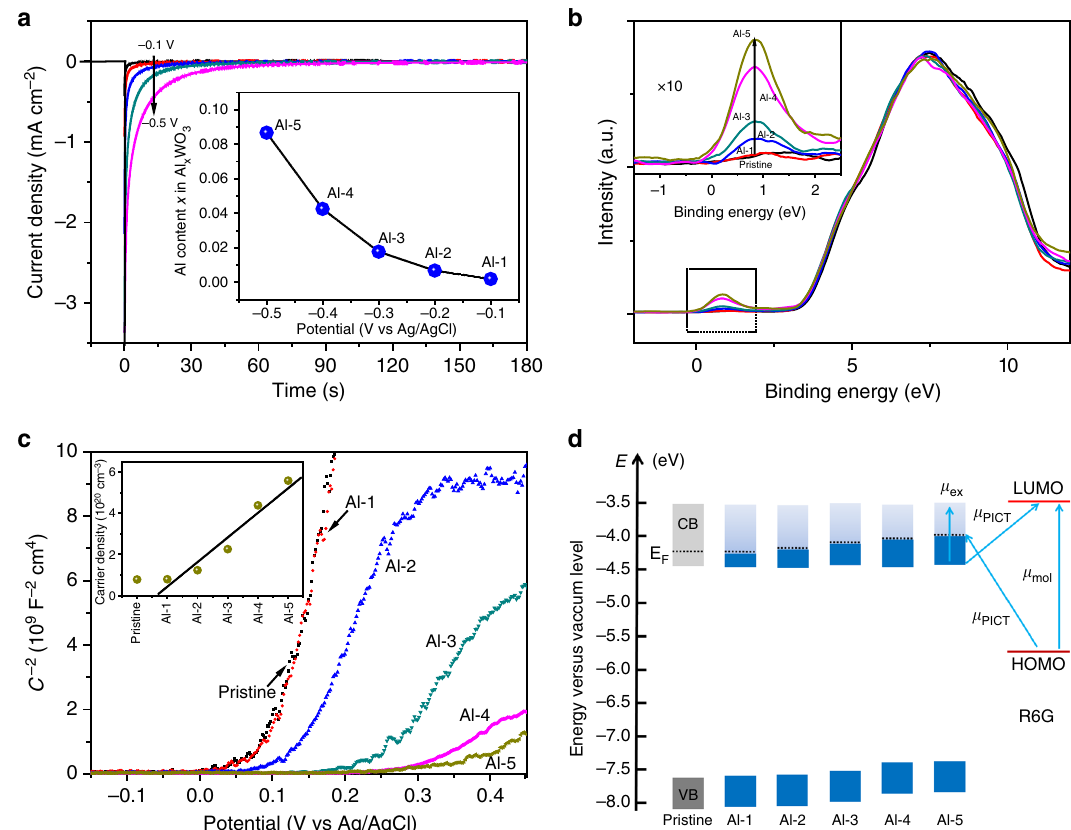
Fig. 4 Systematic manipulation of the electronic structures. a Chronoamperogram of Al-intercalated tungsten oxide fi lms under an applied potential from − 0.1 to − 0.5 V vs. Ag/AgCl, denoted as Al-1, Al-2, Al-3, Al-4, and Al-5, respectively. Inset shows the number of intercalated Al ions in the Al x WO compositions as a function of applied potential. b X-ray photoelectron spectroscopy (XPS) valence-band spectra, and c Mott – Schottky plots for the pristine and Al-intercalated tungsten oxide fi lms obtained at different voltages, ranging from − 0.1 to − 0.5 V. Inset of b shows the peaks near the Fermi levels with an expanded Y -axis. Inset of c shows density of charge carriers calculated from the Mott – Schottky plots for pristine WO 3 and Al-intercalated fi lms. d Schematic of band-level diagram for pristine and colored fi lms, illustrating improved charge-transfer transitions between the substrates and analyte molecules (R6G) due to gradual fi lling of the conduction band (CB)